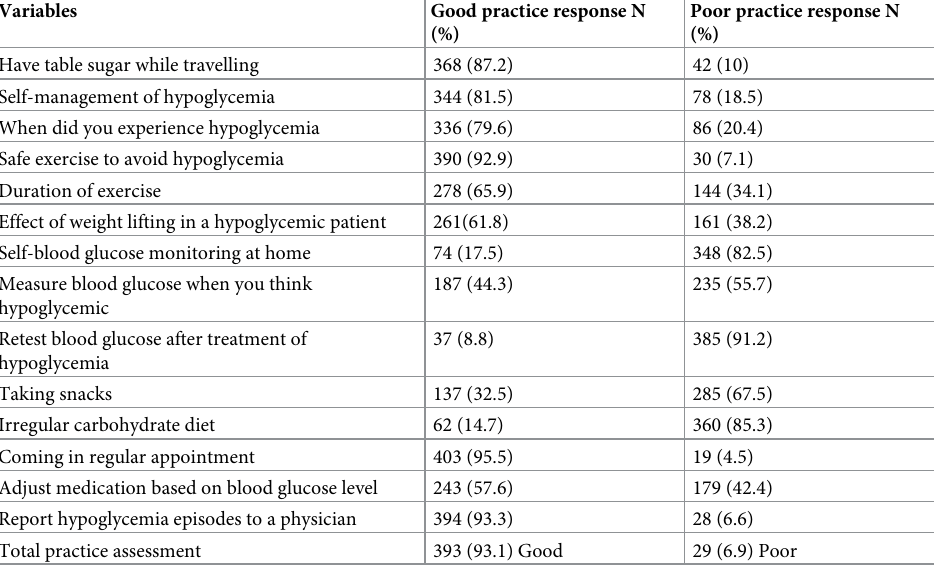
Table 4. Practice regarding hypoglycemia prevention among ambulatory diabetic patients, UoGRTH, North- west- Ethiopia, 2019 (N =